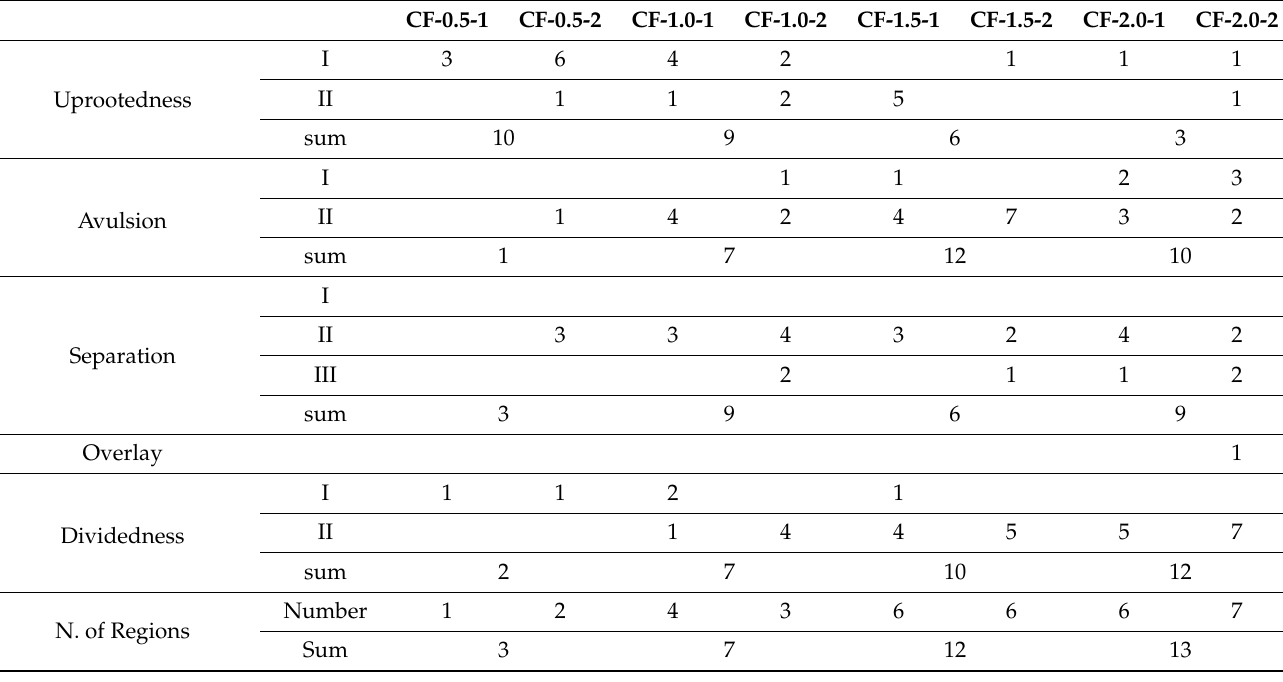
Table 1. T he total numbers of each trace and regions in each prism sample summarized.